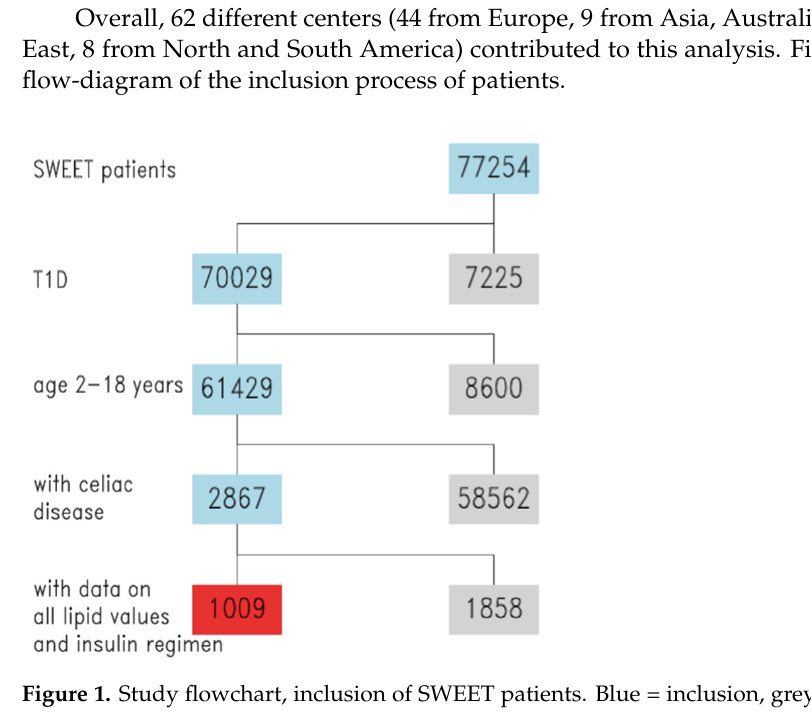
Figure 1. Study flowchart, inclusion of SWEET patients. Blue = inclusion, grey = exclusion, red = final study